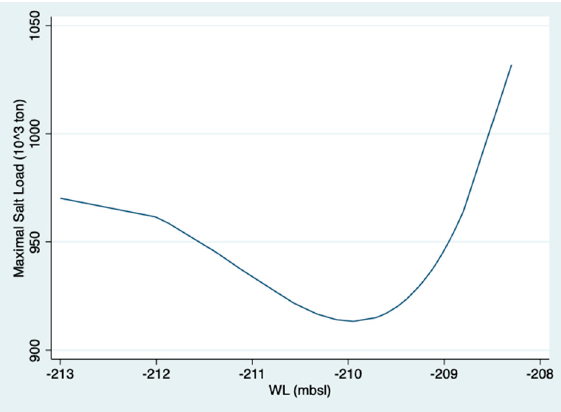
Figure 5. Fractional polynomial regression between annual (1969–2018) maximal salt load (10 3 ton/lake) and annual mean of WL. Salt load is based on chloride concentration (ppm) and maximal lake volume (10 6 m 3 /year; mcm/y), which is respective to WL altitude as published in the morpho- metric map of Lake Kinneret by TAHAL in 1961 [1].